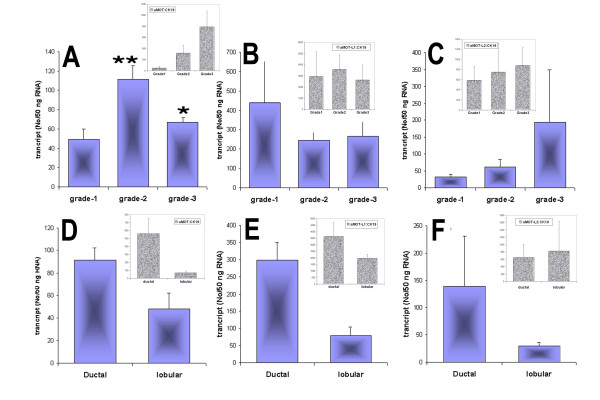
Levels of expression of angiomotins and their relationship with grade (Top panel, A-C) and histological types (bottom panel, D-F). A and D: angiomotin, B and E: angiomotin-like-1, C and F: angiomotin-like-2. ** p = 0.01, * p = 0.049, vs grade 1 tumours. Inserts: respective angiogemotin transcript:CK19 transcript ratio.